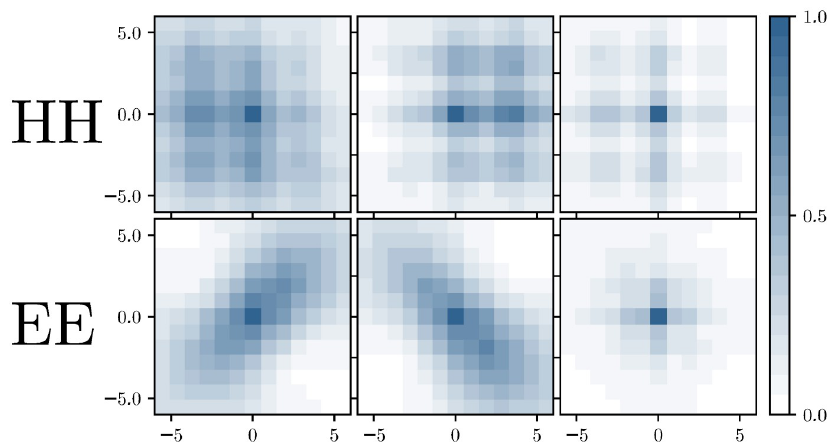
Fig 13. Filters used in the calculation of the filter score. The filters were determined from the inter-domain contact maps in the small MSA, with k -means clustering for k = 3 applied separately for HH and EE contacts.